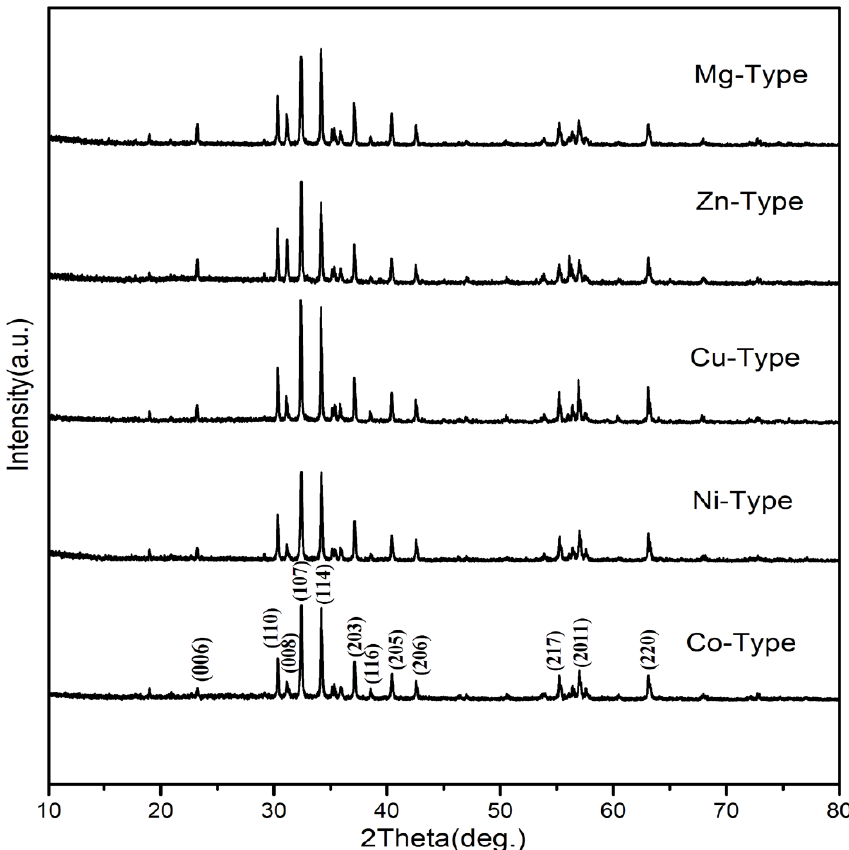
Figure 1. XRD patterns for Sr 0.1 Ca 0.4 La 0.5 Fe 12 O 19 powders with different precursors.